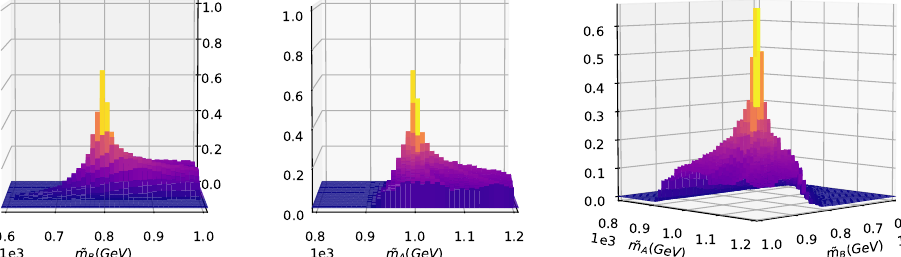
Figure 17 . The same as (cid:12)gure 16, except densities are plotted as a 3D histogram instead of a heatmap. The three (cid:12)gures show the 3D histogram from di(cid:11)erent angles. The peak is at the true mass m = 800 GeV ; m = 1000 B A